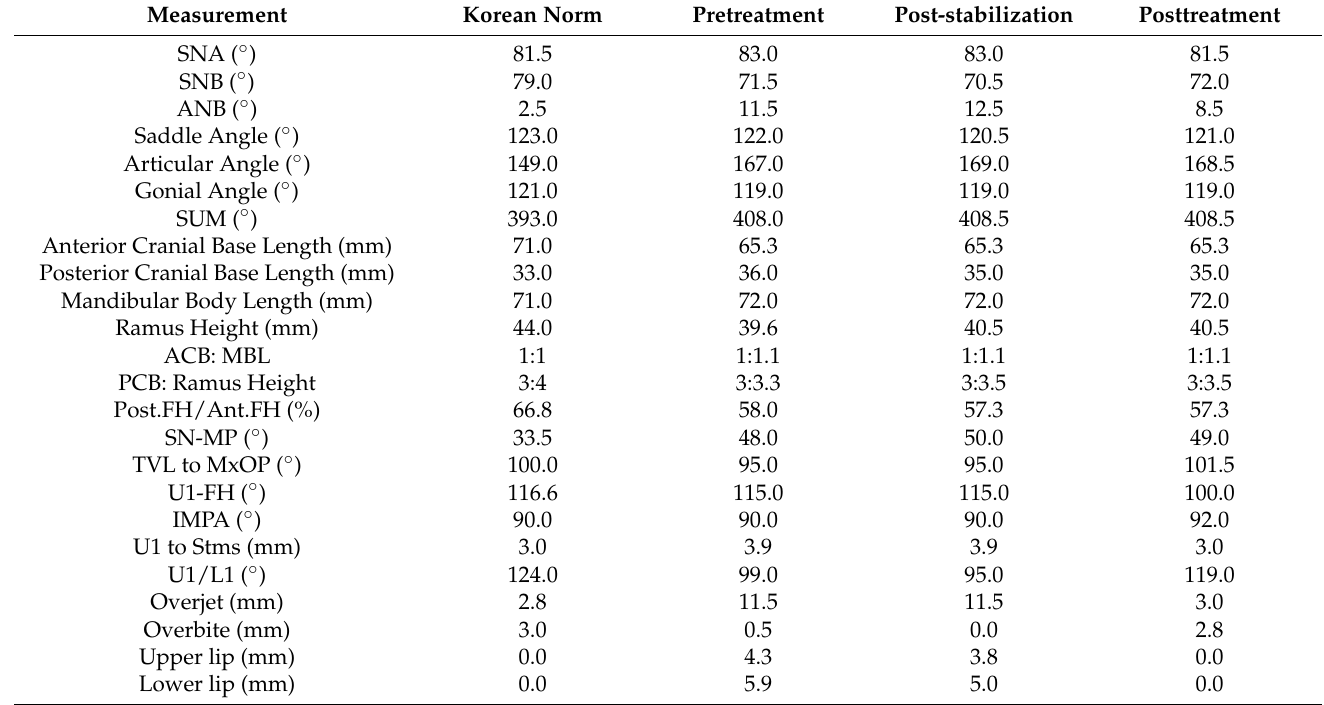
Table 1. Cephalometric